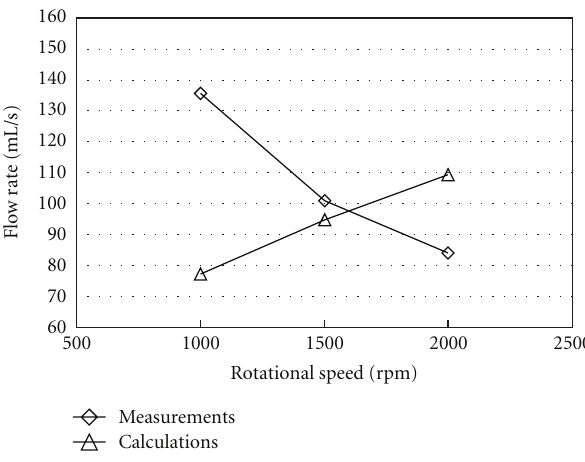
Figure 9: Comparison between experimental and numerical results by using boundary-layer theory.